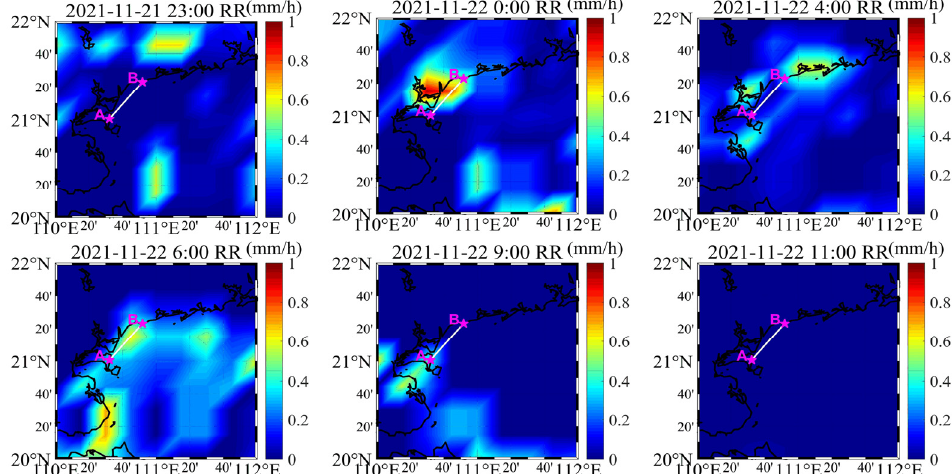
Remote Sens. 2022 , 14 , x FOR PEER REVIEW Figure 11. Spatial distribution of RR in the study area at six typical times. Figure 11. Spatial distribution of RR in the study area at six typical times.